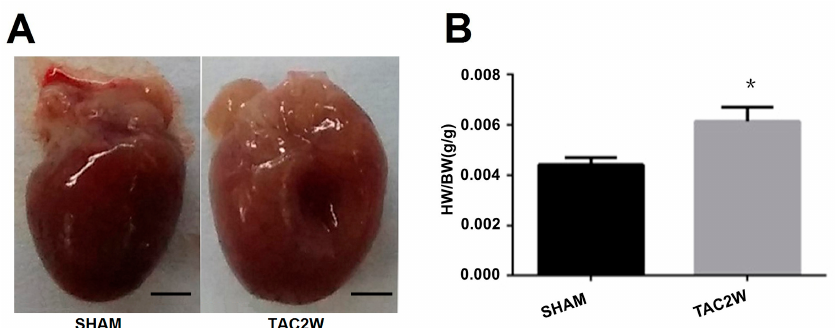
Figure 2. Cont. Figure 2.